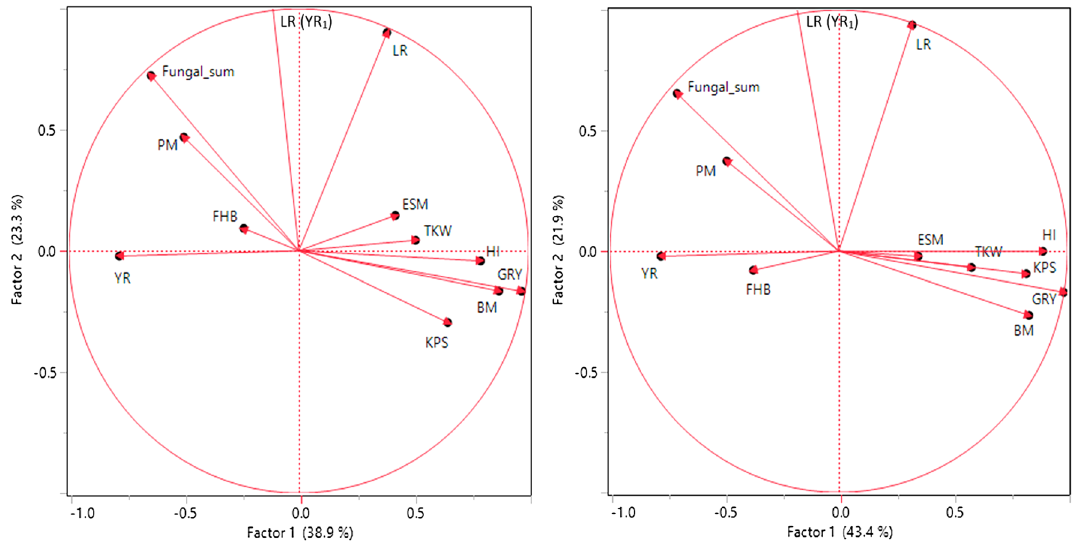
Figure 1. Factor analysis by means of principal component analysis (PCA) of fungal diseases (YR, LR, including subgroup LR (YR 1 ) with low YR infestation < 4.05%, PM, FHB, Fungal sum), grain yield (GRY), and yield components (TKW, KPS, ESM, BM, HI) based on LSmeans (treatment-specific, over years and repeats) at two N levels (left 110 kg N ha −1 , right 220 kg N ha −1). Factors PC1 and PC2 explained 38.9% (43.4%) and 23.3% (21.9%) of the phenotypic variance, respectively. YR stripe rust, LR leaf rust, PM powdery mildew, FHB Fusarium head blight, GRY grain yield, KPS kernels per spike, TKW 1000 kernel weight, ESM ears per square meter, BM biomass, HI harvest